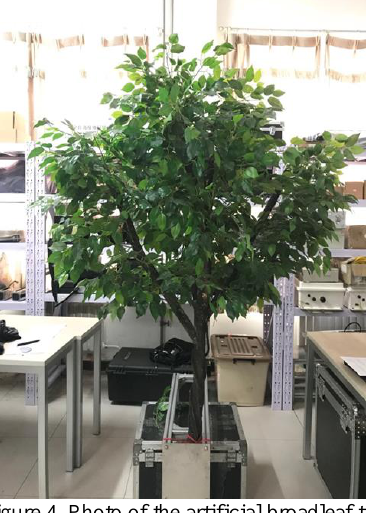
Figure 4. Photo of the artificial broadleaf tree The height of the artificial tree is 2m. The size of each leaf is inclination angle of 360 leaves in total. The average inclination angle was 53.22°. Figure 5 shows the LAD histogram with manual measurement.